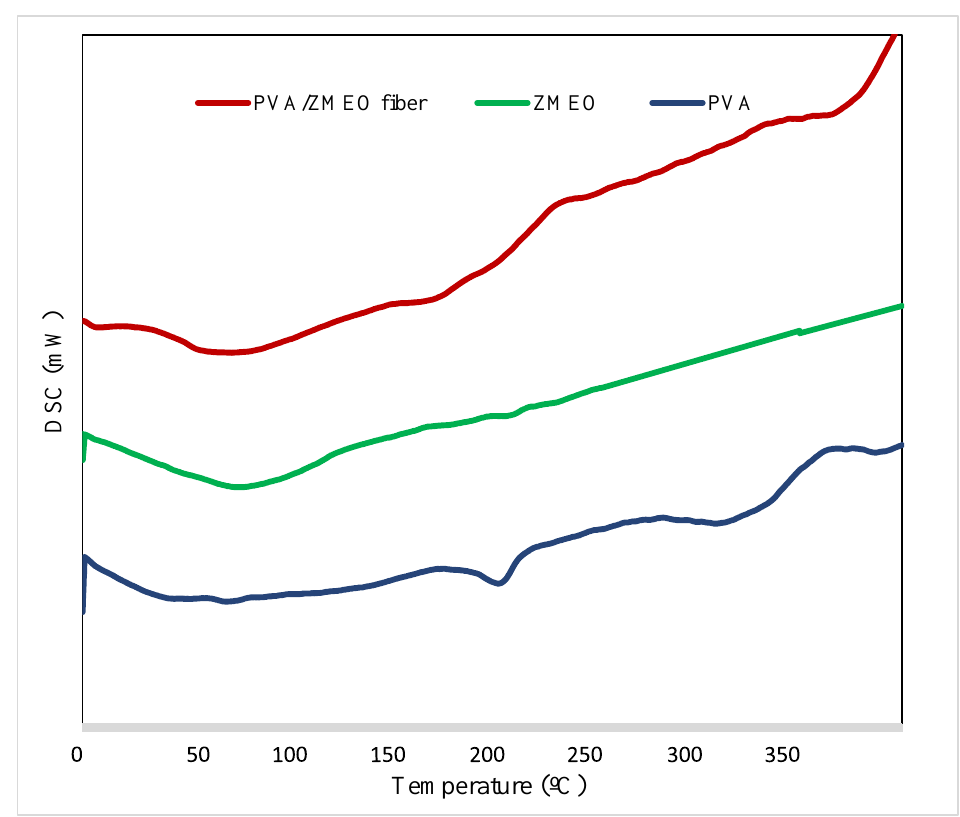
Figure 3. DSC (differential scanning calorimeter) thermograms for PVA powder, ZM essential oil, PVA/ZMEO fiber.